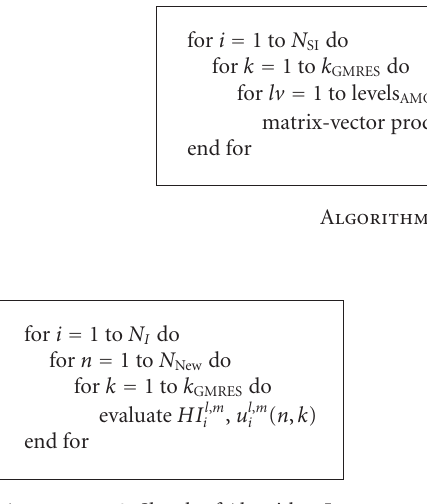
Algorithm 3: Sketch of Algorithm